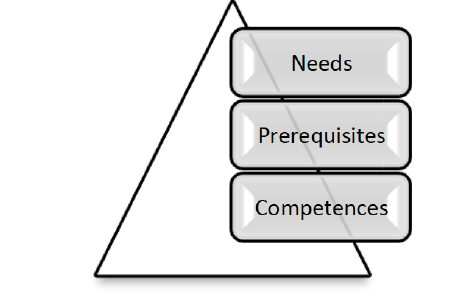
Figure 1. The adaptation in Learning Objects